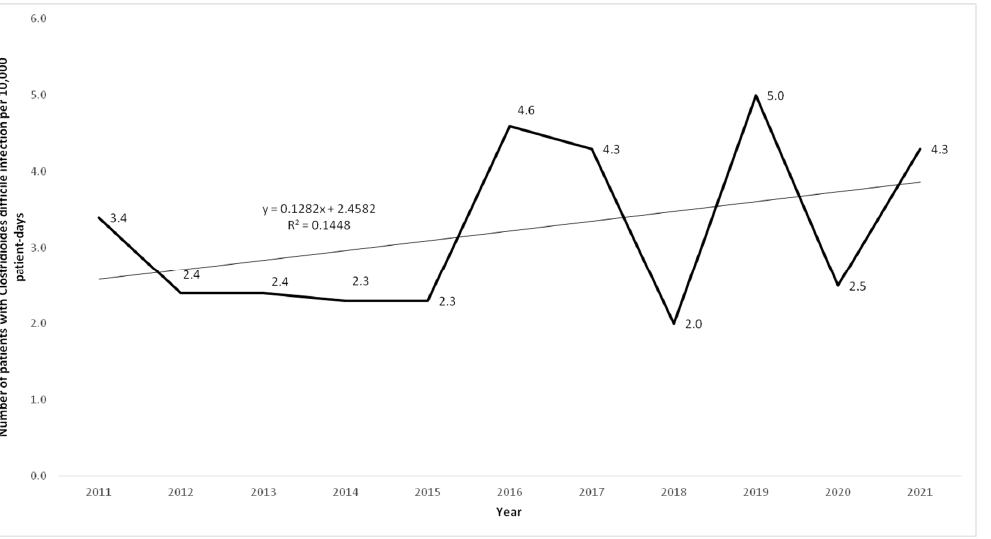
Figure 1. Incidence density (per 10,000 patient-days) of Clostridioides difficile in the tertiary university hospital in Serbia, 2011–2022.